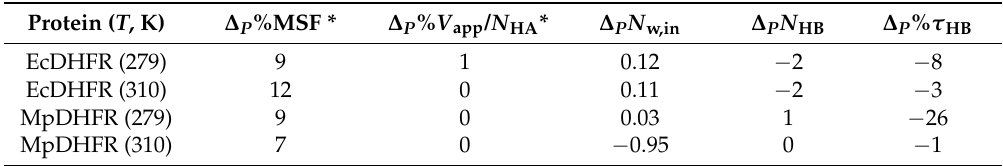
Table 3. Changes of average properties for EcDHFR and MpDHFR with pressure at constant temperature T , where ∆ P indicates a change from 1 to 220 bar and percentages are with respect to the 1 bar value. Note that MpDHFR is close to its melting temperature at 310 K. Protein ( T , K) ∆ P %MSF * ∆ P % V app /N HA * ∆ P N w,in ∆ P N HB ∆ P % τ